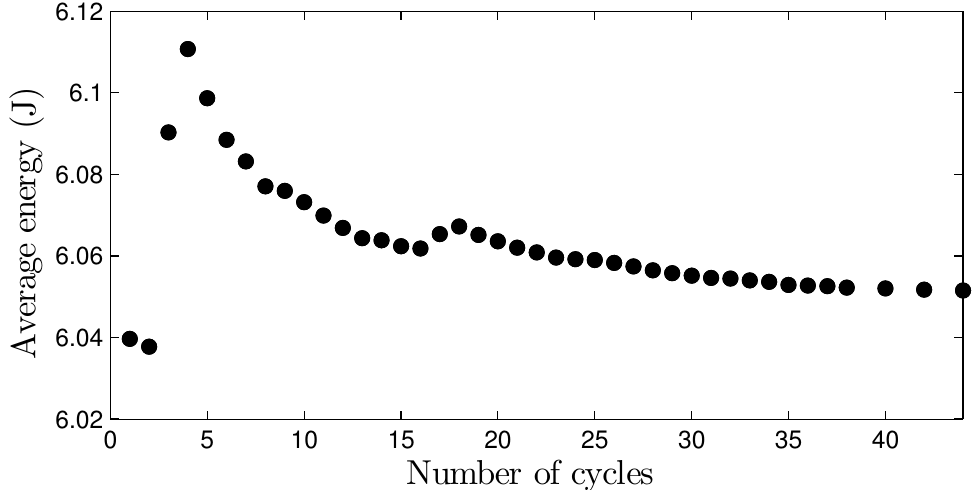
Figure 3. Variability of average energy production as a function of the number of cycles taken into account for